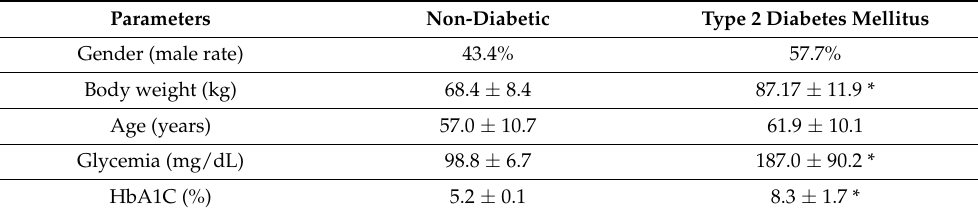
Values are expressed as mean ± S.D; * Significantly different compared to